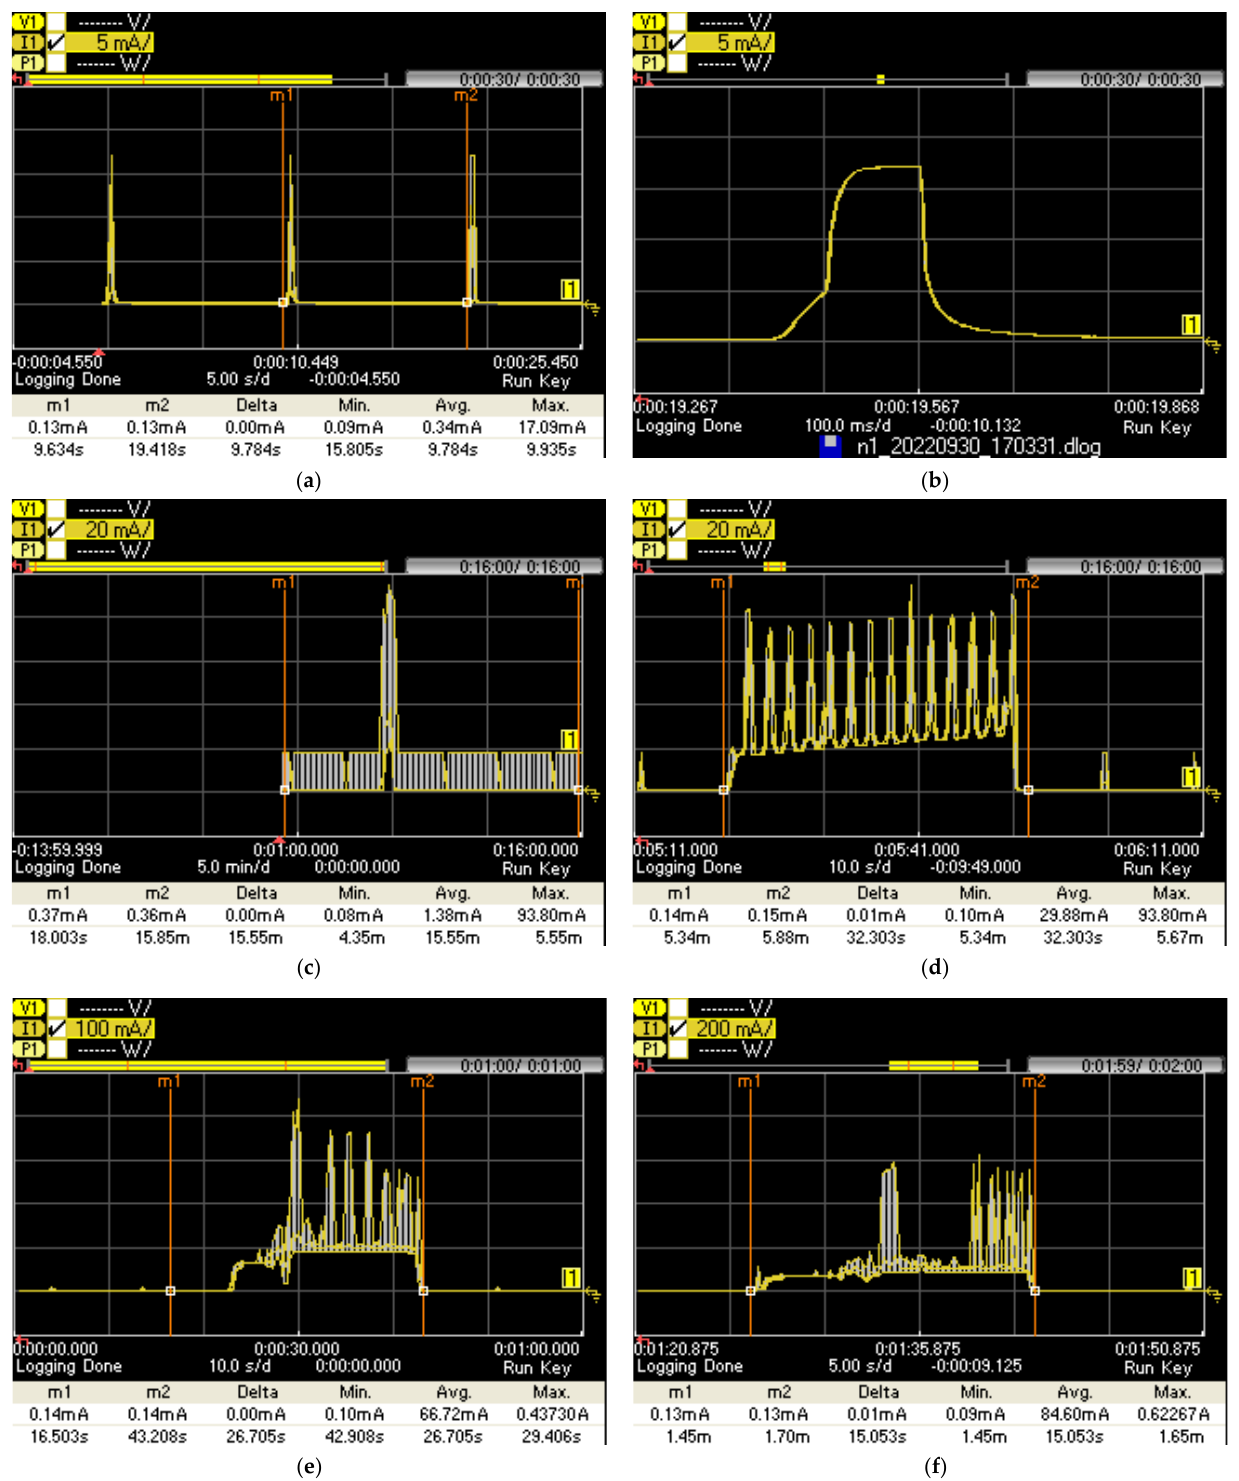
Figure 17. Screenshots of DC power analyzer for measuring current consumption of the hub node: ( a ) markers covering the 8 s cycle with one peak current wave; ( b ) zoomed-in view of the peak current wave in ( a ) when the LoRa transceiver is in receive mode; ( c ) markers covering a 15 min cycle that includes a reading of the sensors and several LoRa transceiver receive modes; ( d ) zoomed-in view of the peak wave in ( c ) when reading the sensors; ( e ) markers covering the data transmission during midnight using LTE; ( f ) markers covering the 15 s duration after a fire event.